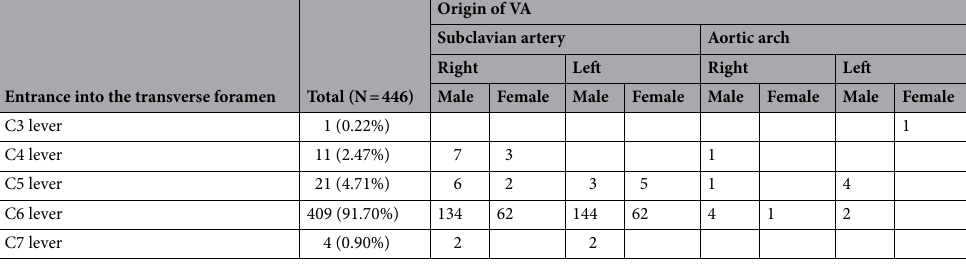
Entrance into the transverse